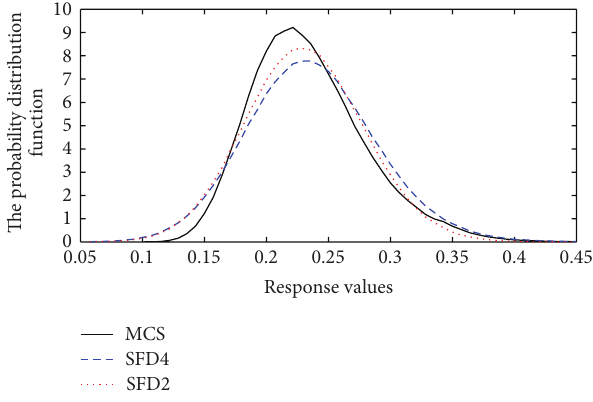
Figure 6: The pdf at point 𝐷 using SFDHC and MCS.